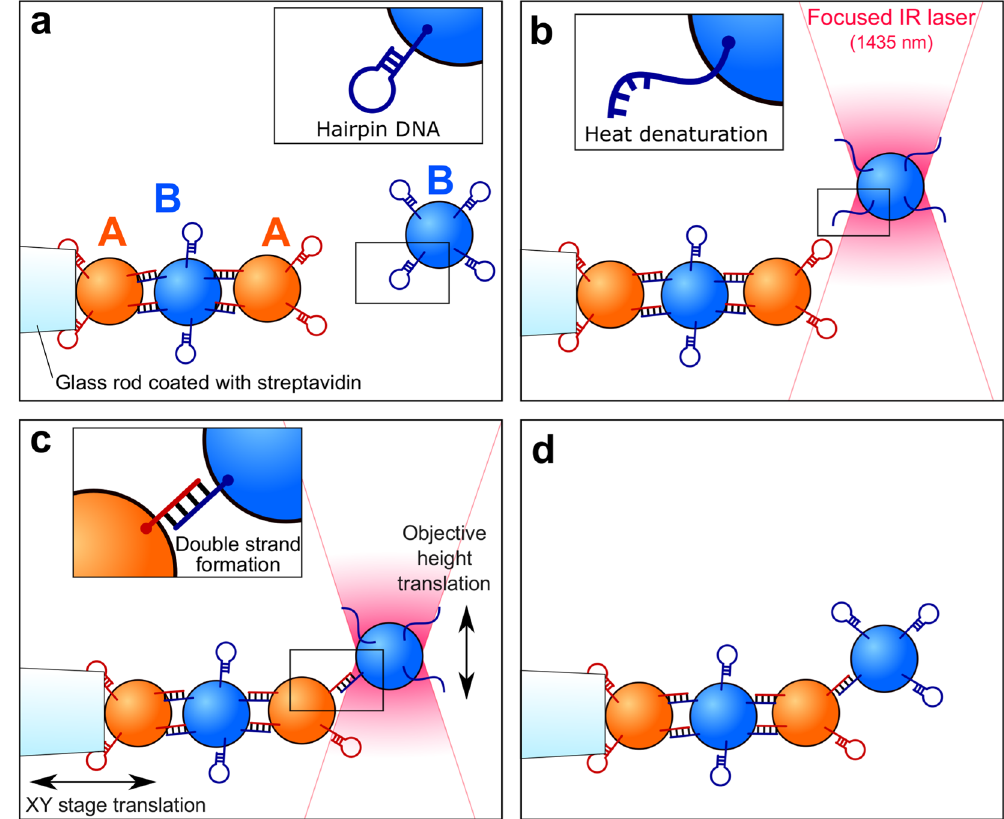
Figure 1. The assembly of microscopic structures by heat bonding. ( a ) Particles that serve as assembling bricks are suspended in a buffer. A complementary pair of hairpin DNA strands, A (red) and B (blue), are modified on the particles. ( b ) An infrared laser (1435 nm) focused under a microscope can trap the particle and manipulate it in three dimensions. Simultaneously, the same focused laser heats the water locally, causing the hairpin DNA strands on the particle surface to unfold. ( c ) The trapped particle is brought close to the structure by translating the chamber in the X and Y directions and the objective lens in the Z direction. The hairpin DNA strands on the side of the structure are also unfolded. The complementary DNA strands on the particles form double strands and connect the particles. ( d ) The particle remains connected to the structure even after the laser is turned off because of the hysteresis nature of the hairpin DNA strands (Fig.